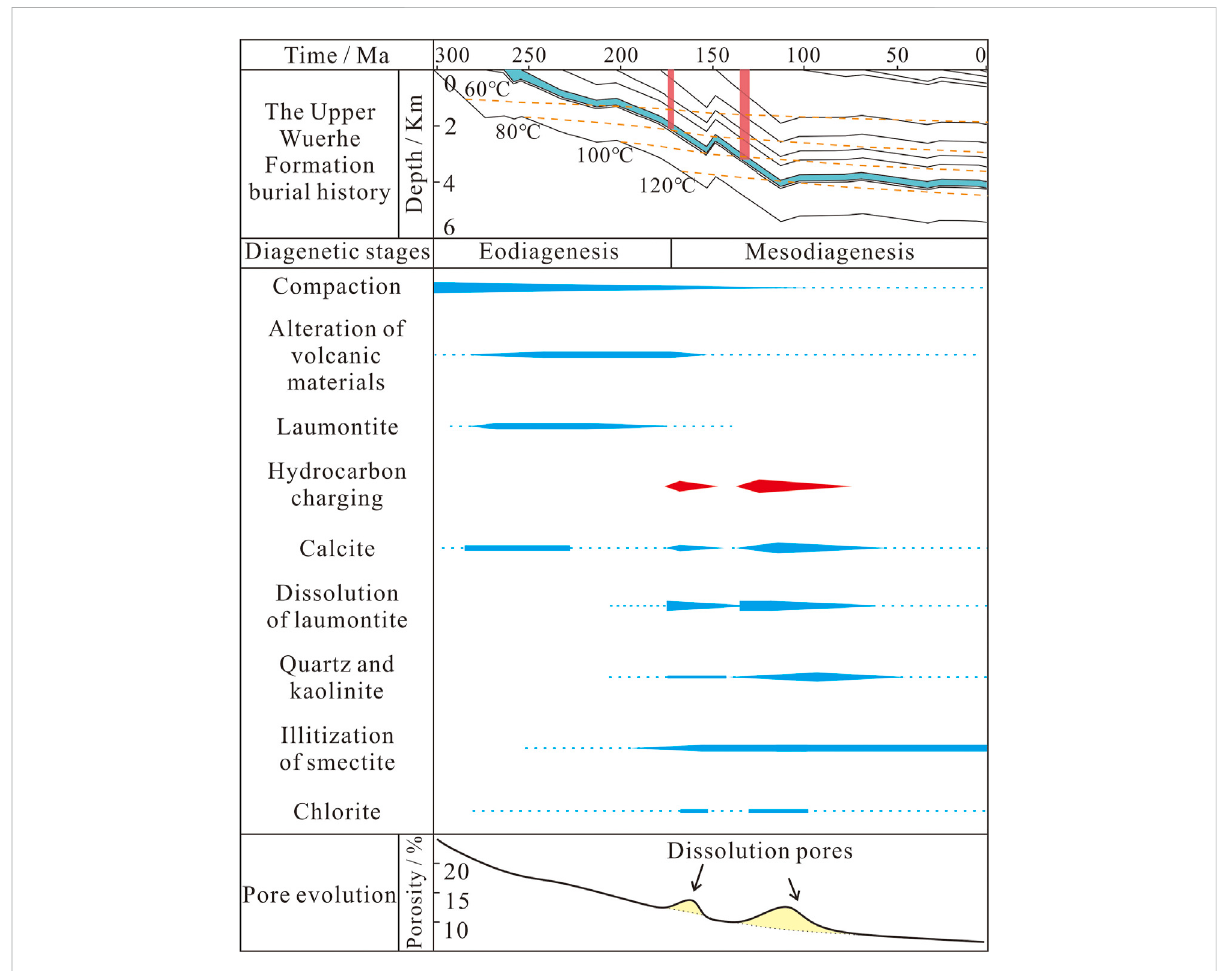
FIGURE 9 Integrated diagenetic evolution based on petrology and burial and thermal histories and their effect on the porosity of the P 3 w sandy conglomerates. The burial history and thermal evolution of P 3 w is taken from Well ZJ1. The stratigraphy is from Wang (2016), and the tectonic and geothermal evolution data are from Qiu et al.